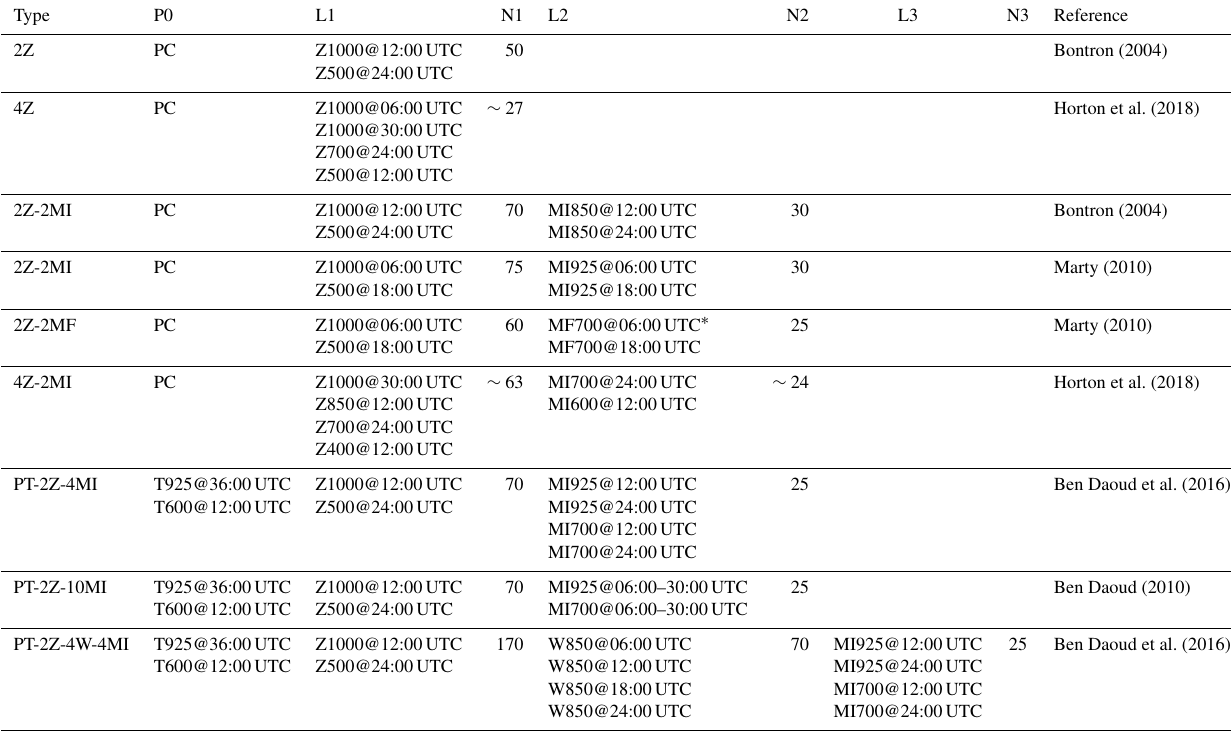
Table 2. Some existing analog methods listed by increasing complexity. P0 is the preselection (PC: on a calendar basis, which is ± 60d around the target date), and L1, L2, and L3 are the subsequent levels of analogy. N1, N2, and N3 are the number of analogs to select at each level of analogy. The meteorological variables are the following: Z – geopotential height, T – air temperature, W – vertical velocity, MI – moisture index, which is the product of the relative humidity at the given pressure level and the total water column, and MF – moisture flux, which is the product of MI with the wind intensity. The analogy criterion is S1 for Z and RMSE for the other